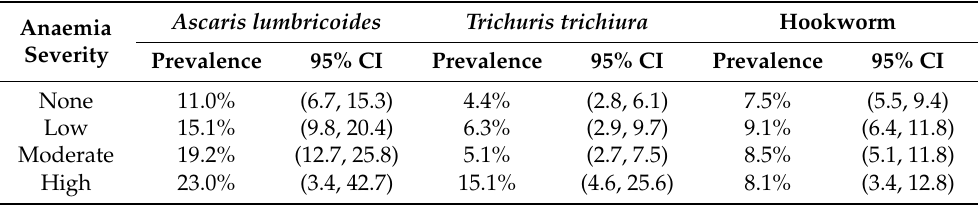
Table 2. Prevalence of soil-transmitted helminthiases in school-aged children classified according to their anaemia severity in Burundi, 2008–2011.